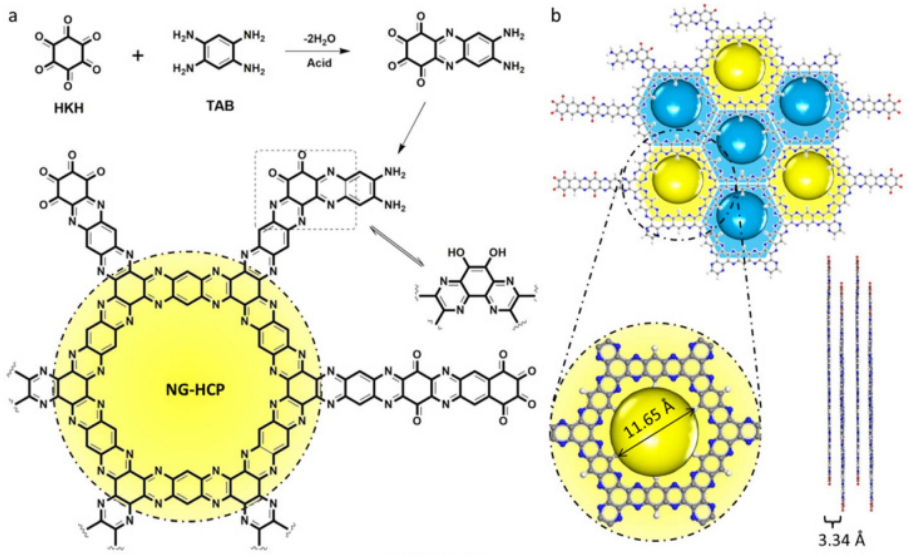
Figure 6. ( a ) Synthetic route of obtaining HG-HCP by a dehydration–condensation reaction between hexaketocyclohexane (HKH) octahydrate and 1,2,4,5-tetraaminobenzene (TAB) tetrahydrochloride in NMP solution with sulphuric acid as a catalyst and a schematic illustration of the alternative pristine NG-HCP structure, where many excessive amino and carbonyl functional groups exist at the edge; ( b ) molecular configuration of a single layer of the NG-HCP with a pore size of 11.65 Å and a packing distance of 3.34 Å. Reprinted from Ref. [90], Copyright 2017, with permission from Elsevier.